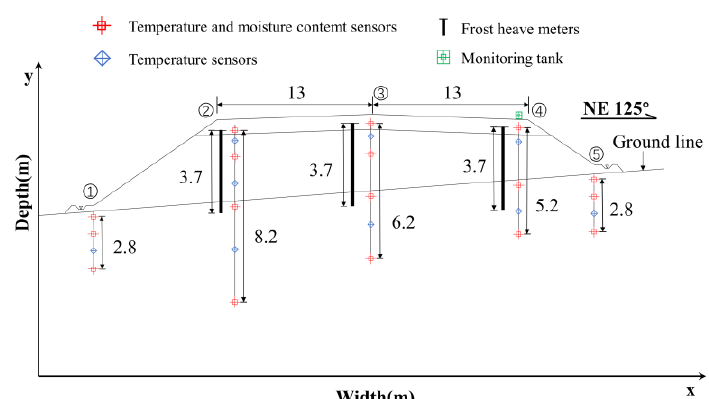
Figure 1. Study area.